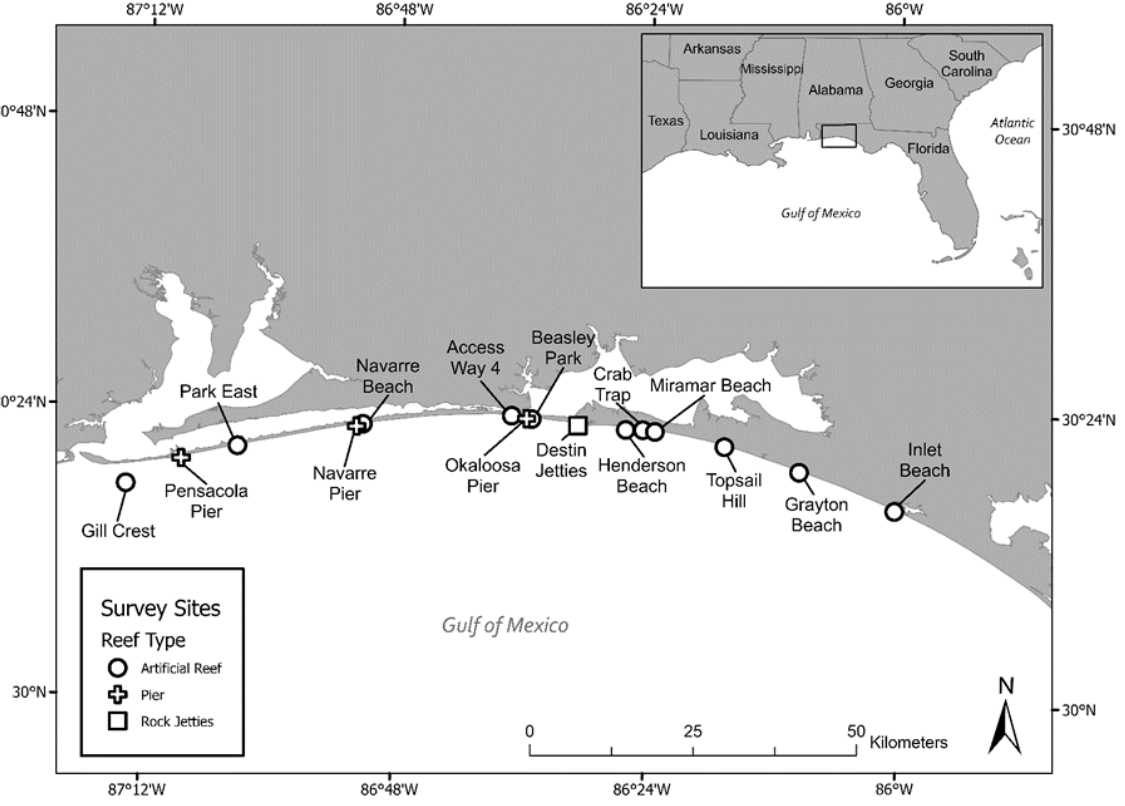
Figure 1. Map indicating field sites along the nGOM from Gill Crest Reef located off Pensacola Beach, Florida to Inlet Beach west of Panama City Beach, Florida.